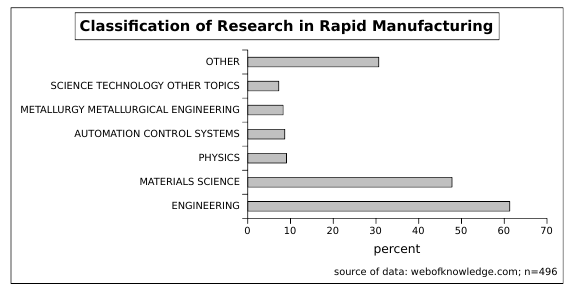
Figure 5. Classification of articles for Rapid Manufacturing; source of data: webofknowledge.com.